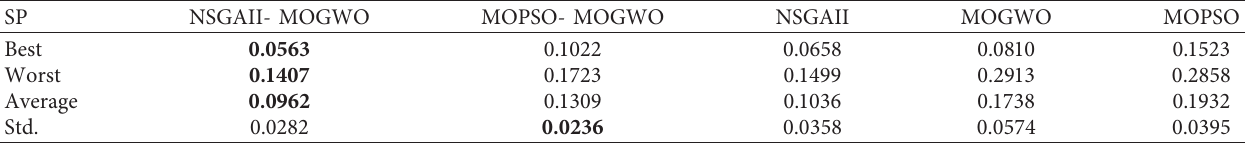
Table 14: Results of SP for five algorithms in ten independent runs.